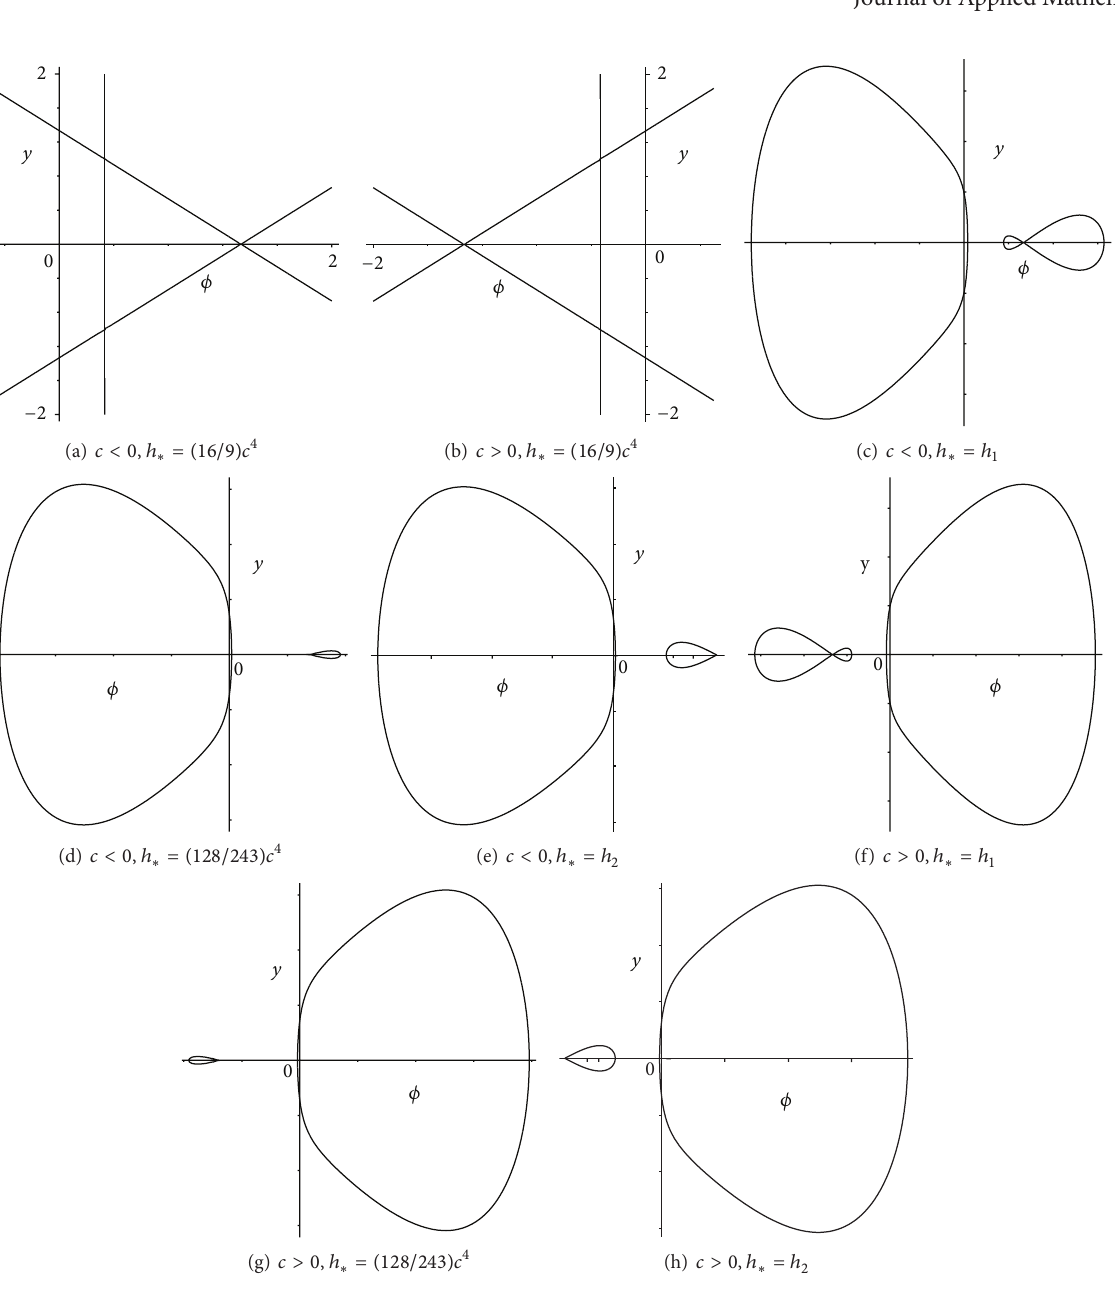
Figure 4: The level curves of system (13) defined by ℎ = ℎ ∗